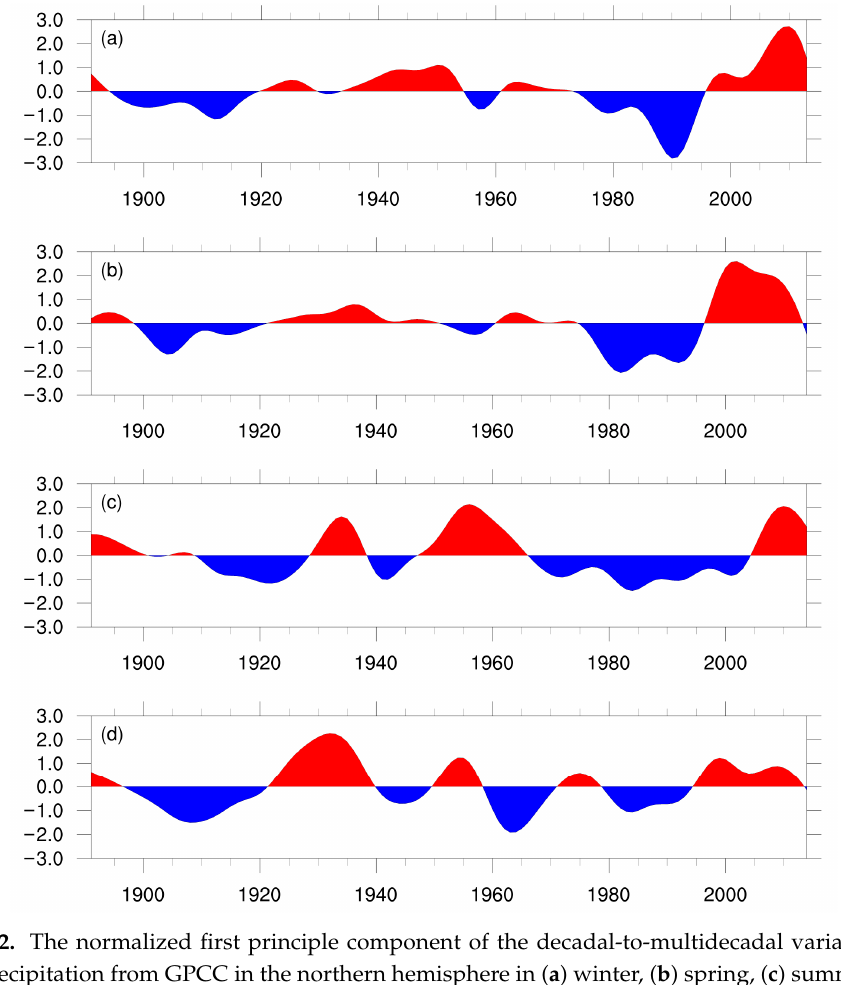
Figure 2. The normalized first principle component of the decadal-to-multidecadal variability of land precipitation from GPCC in the northern hemisphere in ( a ) winter, ( b ) spring, ( c ) summer, and ( d ) autumn.